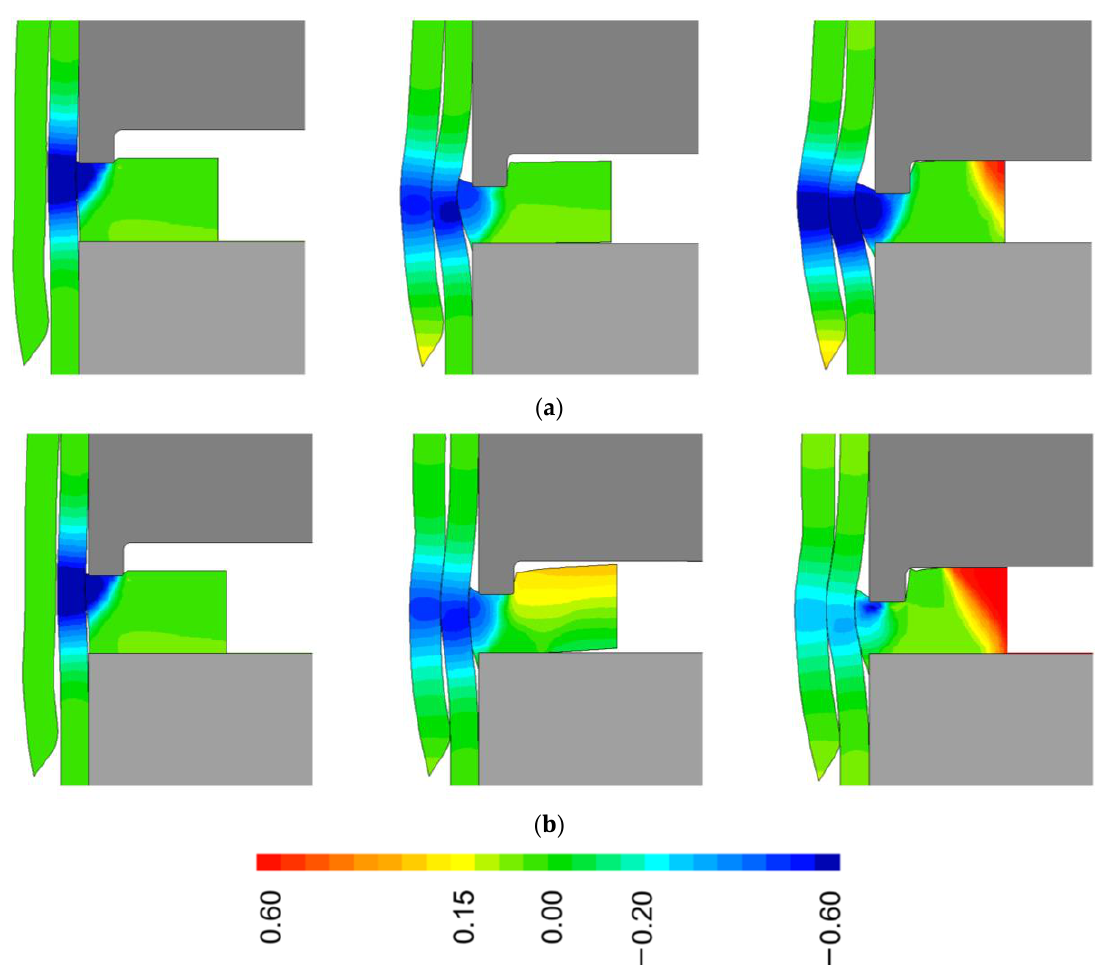
Figure 8. Evolution of the normalized radial velocity v r / v 0 for ( a ) two PVC tubes and ( b ) a PVC– aluminum tube combination at the start, intermediate and final stages of the process.